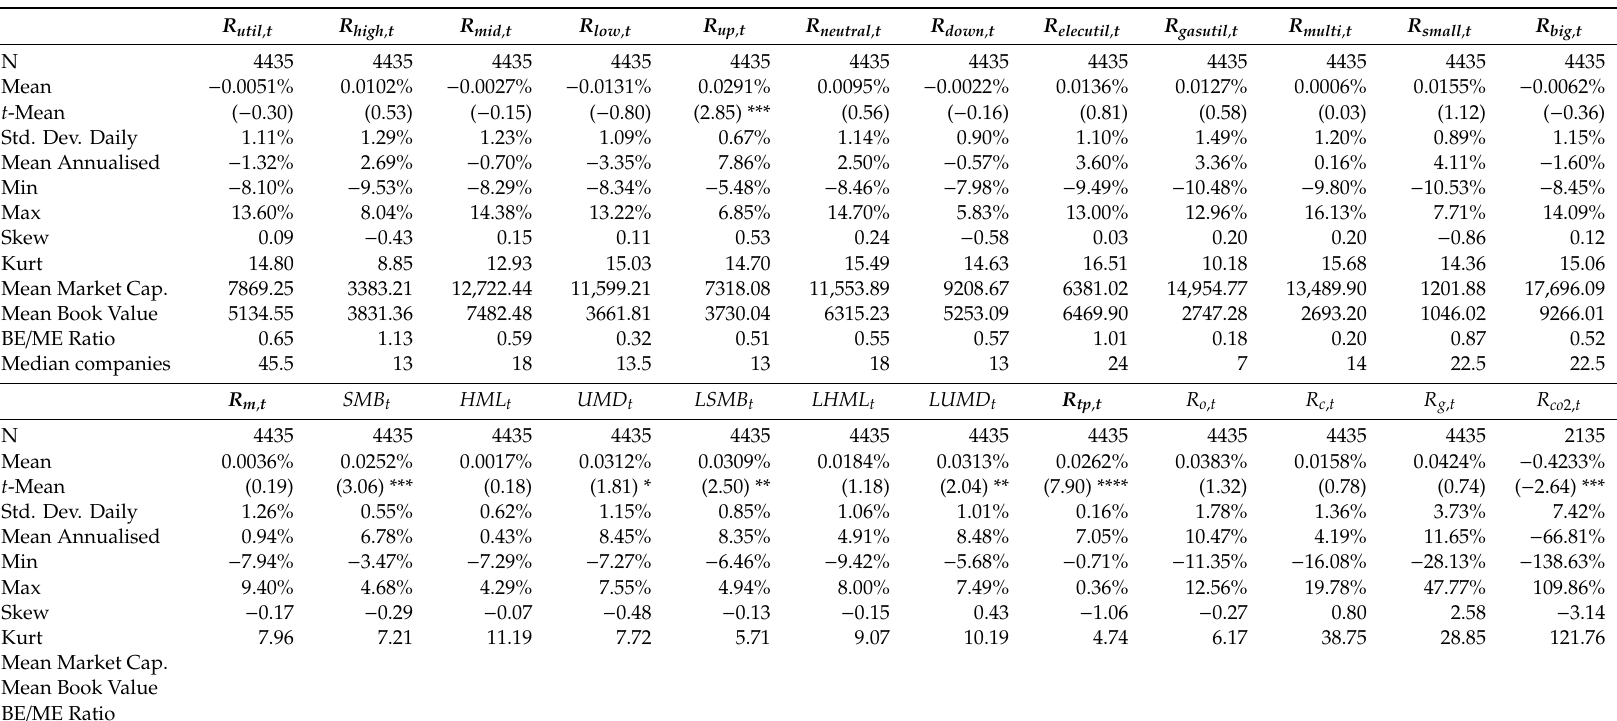
Table 1. Summary statistics for the portfolios and risk